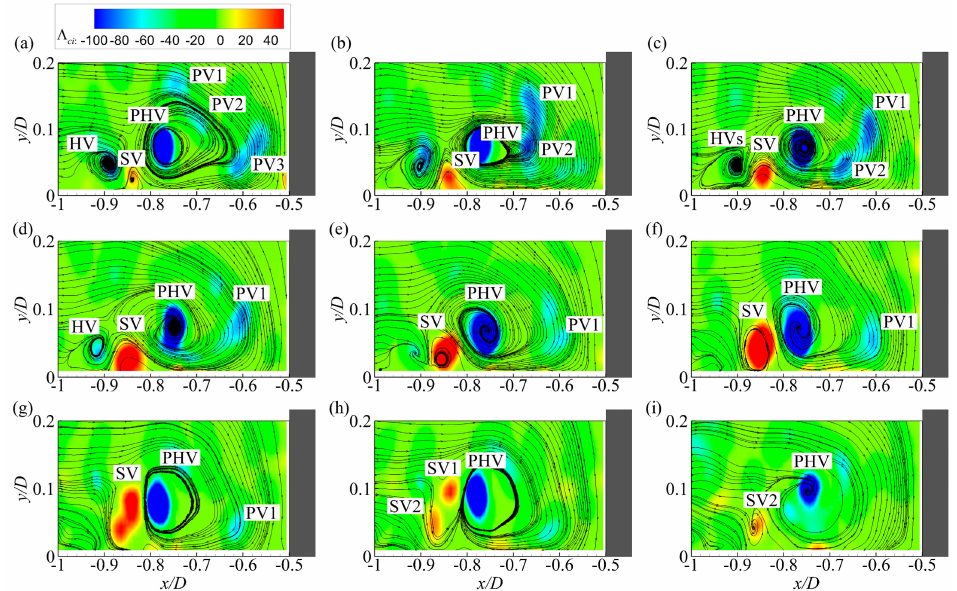
Figure 14. Sequence of instantaneous velocity fields illustrating the interactions between a PHV and other vortices for case C13900. ( a ) t = 0; ( b ) t = 0.17 D / U m ; ( c ) t = 0.34 D / U m ; ( d ) t = 0.51 D / U m ; ( e ) t = 0.68 D / U m ; ( f ) t = 0.84 D / U m ; ( g ) t = 1.02 D / U m ; ( h ) t = 1.18 D / U m ; ( i ) t = 1.35 D / U